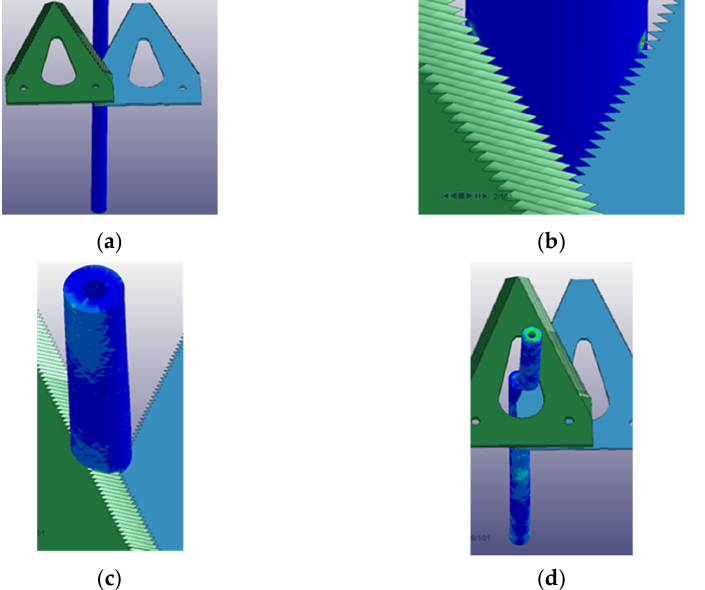
Figure 8. Stem cutting process of wild chrysanthemum: ( a ) before the cut, ( b ) cutting starts, ( c ) halfway cut and ( d ) total cut.